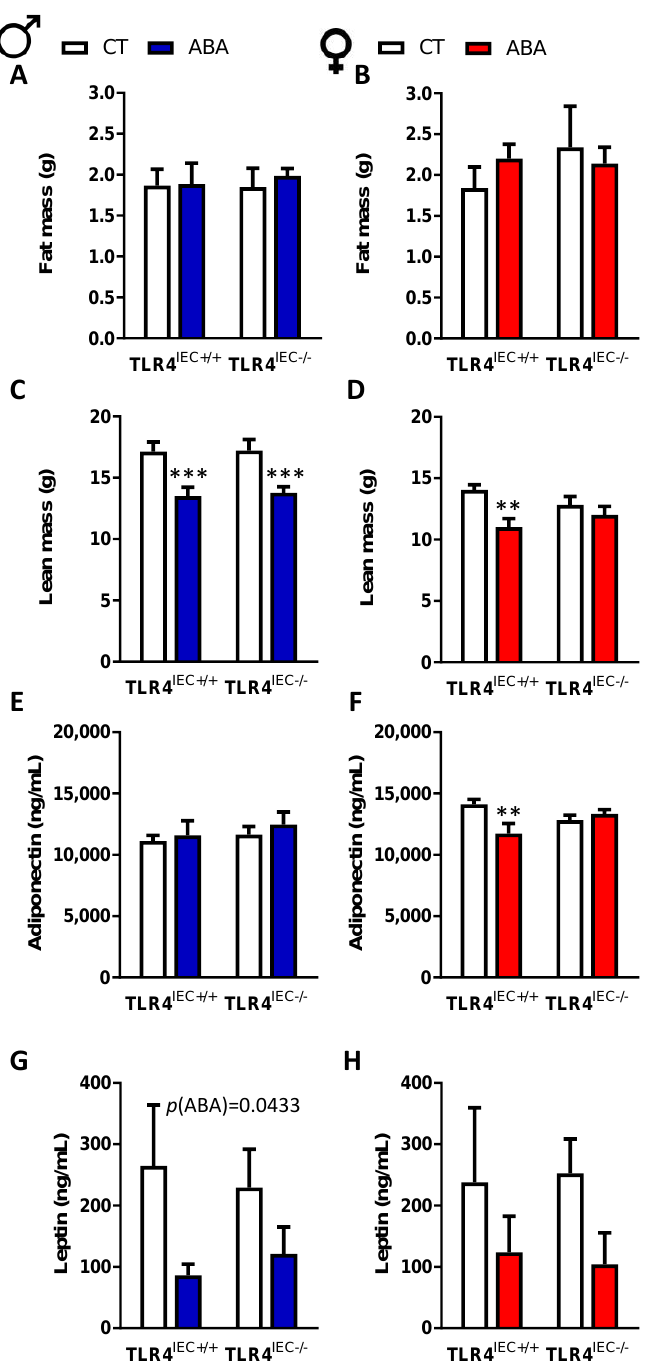
Figure 3. Body composition at day 17 and the plasma leptin and adiponectin levels in male and female mice. Fat ( A ) and lean mass ( C ) in TLR4 IEC+/+ and TLR4 IEC − / − CT (open bars) and ABA (blue bars) male mice. Fat ( B ) and lean mass ( D ) between TLR4 IEC+/+ and TLR4 IEC − / − CT (open bars) and ABA (reds bars) female mice. Adiponectin ( E ) and leptin ( G ) plasma level in TLR4 IEC+/+ and TLR4 IEC − / − CT (open bars) and ABA (blue bars) male mice. Adiponectin ( F ) and leptin ( H ) plasma level in TLR4 IEC+/+ and TLR4 IEC − / − CT (open bars) and ABA (reds bars) female mice. The results of the Bonferroni post hoc tests are shown: **, p < 0.01 and ***, p < 0.001 vs. CT; p < 0.05 vs. TLR4 IEC+/+.